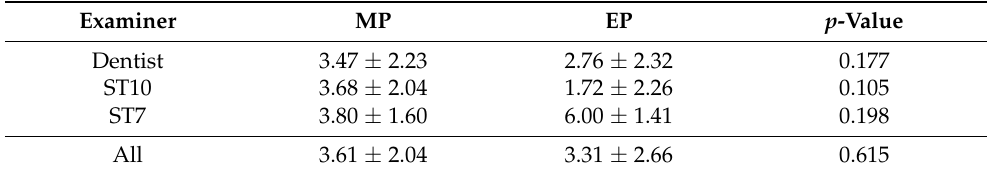
Table 5. Patients ’ pain sensitivity determined by VAS (0 = no pain to 10 = extreme pain) for manual probing (MP) or electronic probing (EP) differentiated by level of examiner ’ s experience (dentist,